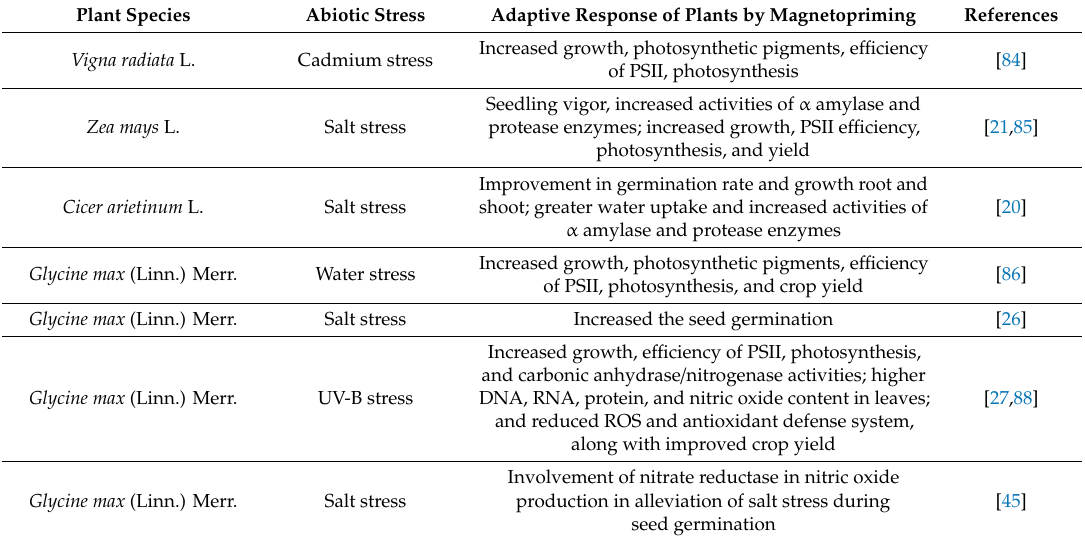
Table 3. The mitigation e ff ect of magnetic fields (MFs) in abiotic